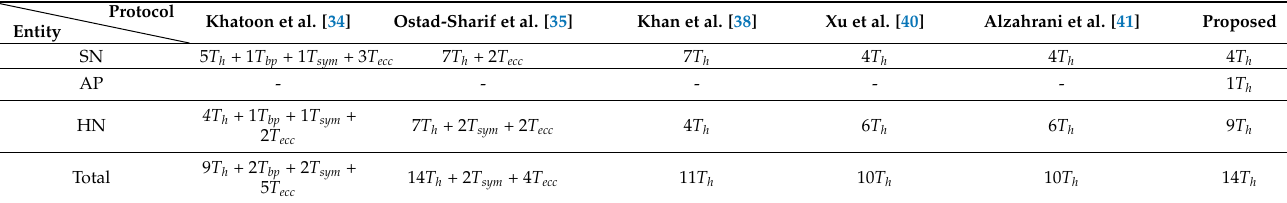
Table 3. Computation cost comparison result.